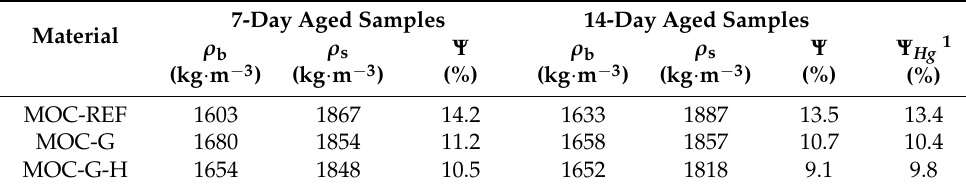
Table 3. Basic structural parameters of the hardened composites.